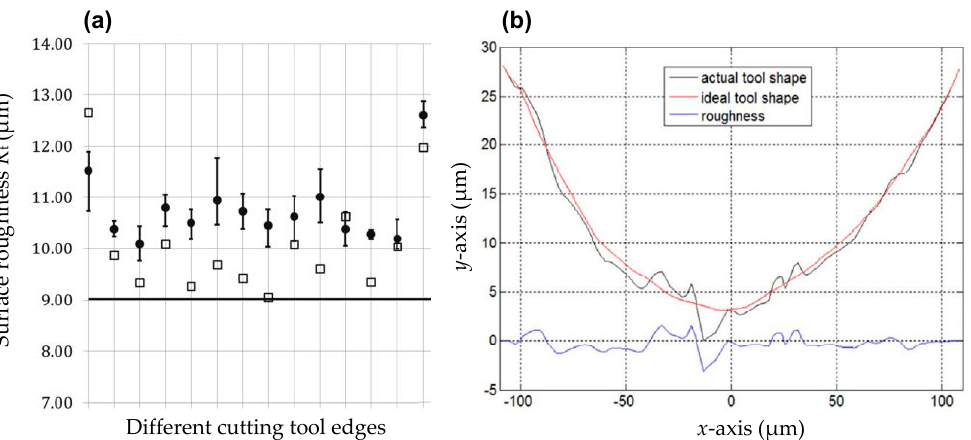
Figure 2. Influence of tool edge waviness on the surface profile: ( a ) Comparisons between the surface roughness results with and without considering tool edge waviness; ( b ) tool edge waviness profile on the diamond tool. Reproduced with permission from [26,29].